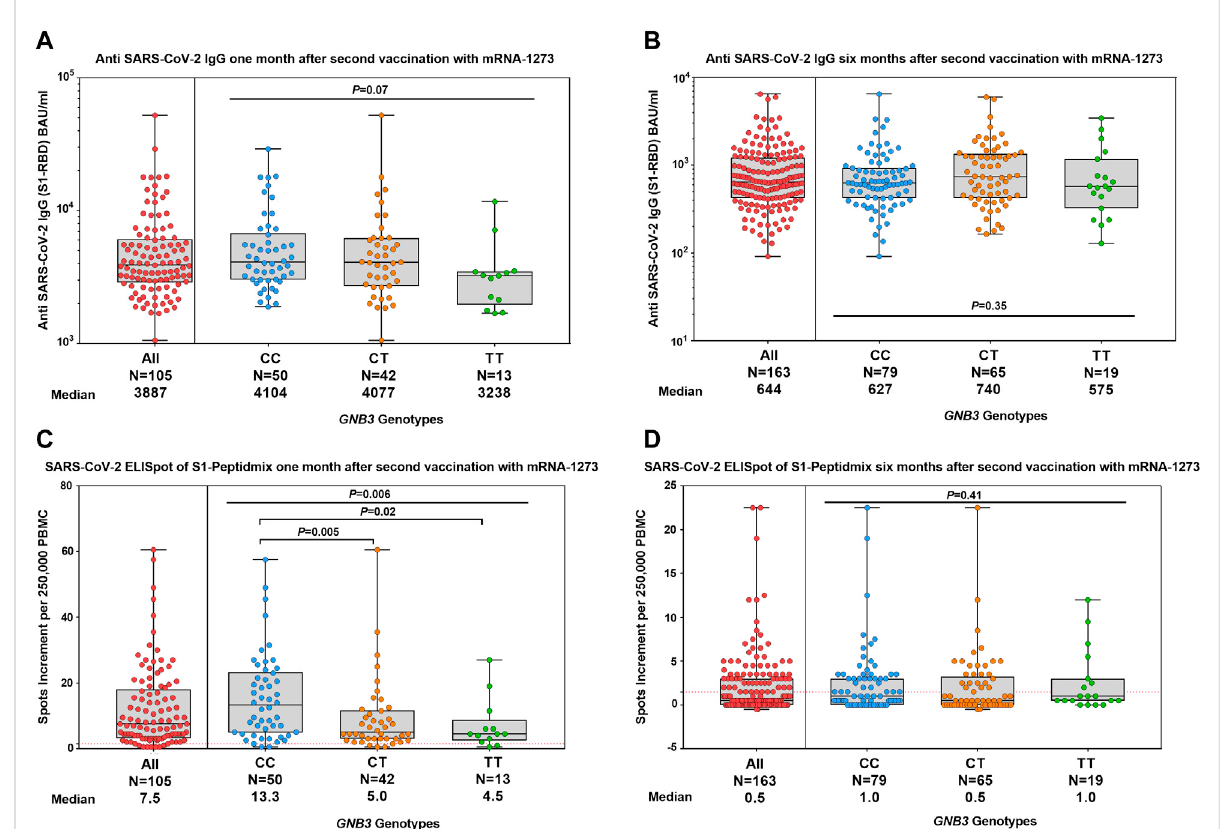
FIGURE 1 Humoral and cellular immune responses were strati fi ed by GNB3 genotypes 1 and 6 months after the second vaccination with mRNA-1273. Distribution of antibody concentrations against SARS-CoV-2 S1-RBD 1 month (A) and 6 months (B) after the second vaccination. ELISpot responses to the S1-protein of SARS-CoV-2 at 1 month (C) and 6 months (D) after the second vaccination. Antibody titers are reported in BAU/ml and T-cell response as spots increment. Red dashed lines indicate the cut-off for positivity (1.5 spots increment per 250,000 peripheral blood mononuclear